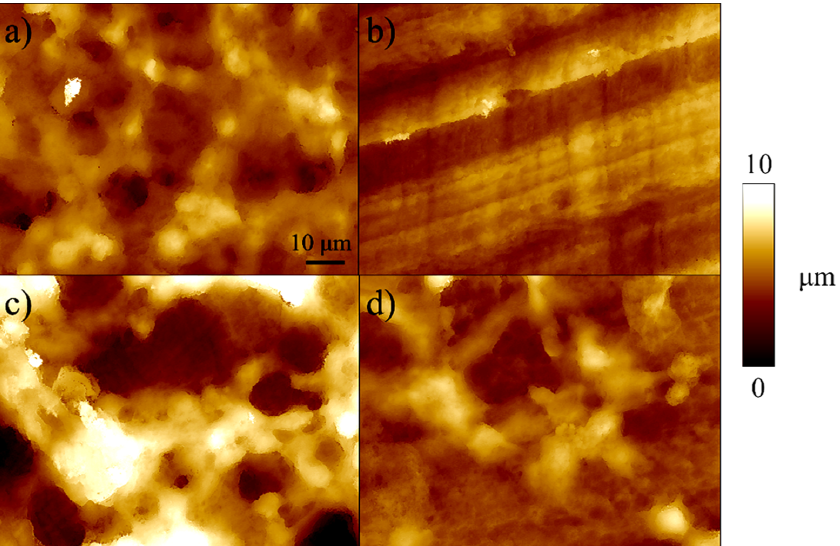
Figure 4. Images of the surface of the dentine substrates after in vitro testing. ( a ) dentine control, ( b ) dentine with bisphosphonate, ( c ) dentine with RANKL, ( d ) dentine with both phosphonate and RANKL.